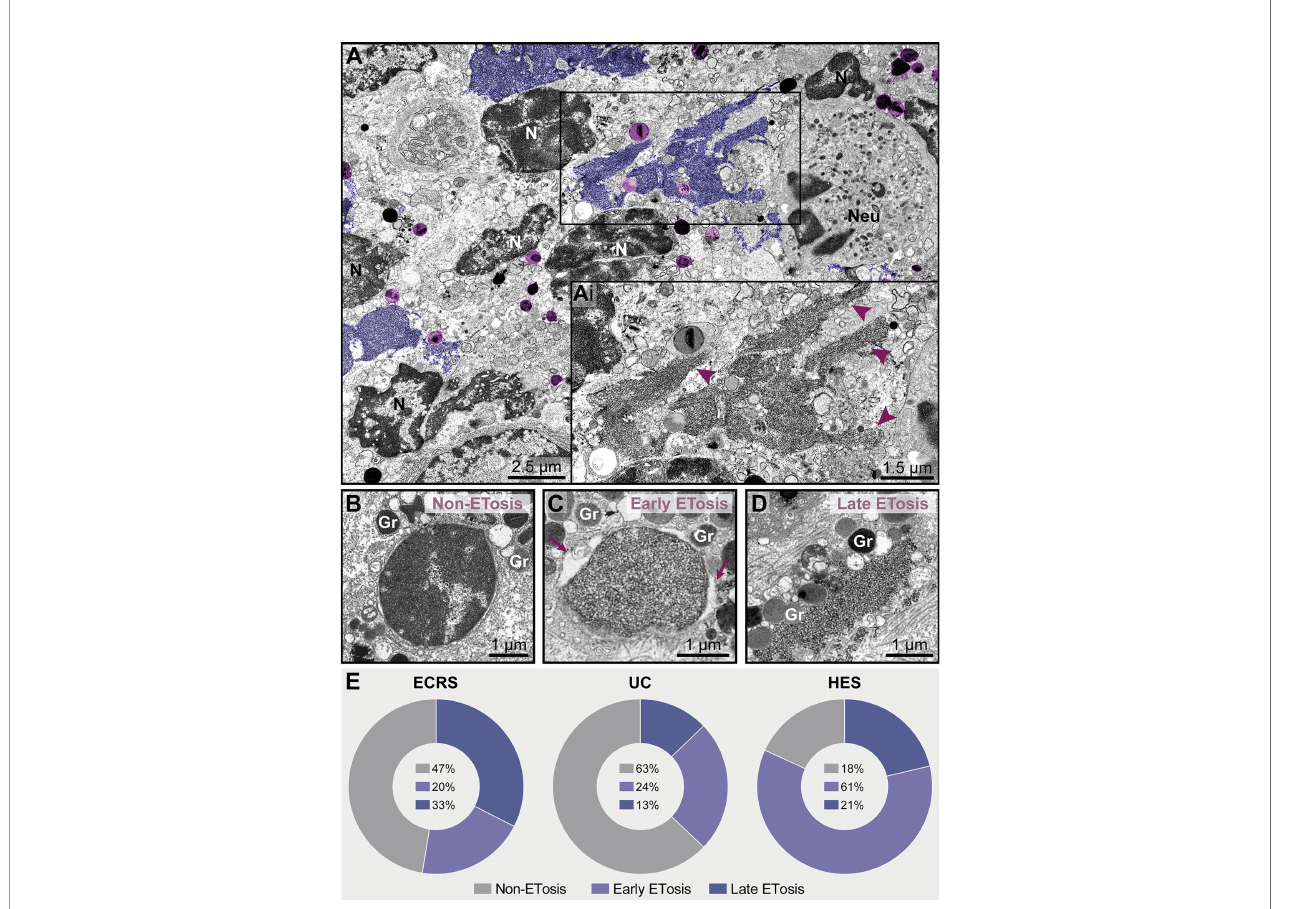
FIGURE 7 | ETosis represents a signi fi cant proportion of cytolytic eosinophils in eosinophil-associated diseases (EADs). (A, Ai) A tissue in fl ammatory site [intestinal ulcerative colitis (UC) biopsy] showing ETotic eosinophils with late signs of ETosis represented by decondensed chromatin spread extracellularly as ETs (colored in purple and indicated by arrowheads in Ai at higher magni fi cation). FEGs (light purple) are in contact with ETs. Note that other non-ETotic eosinophils with nuclei (N) exhibiting heterochromatin (condensed)/euchromatin (decondensed) and a neutrophil (Neu) are seen in the same area. (B – D) Representative electron micrographs from an ECRS biopsy (nasal sinus tissue) highlighting the structural aspect of nuclei in cytolytic eosinophils. While the presence of condensed/decondensed chromatin denotes a non-ETotic eosinophil, eosinophils in early (C) and late (D) processes of ETosis show extensively decondensed chromatin. When in early ETosis (C) , the nuclear envelope is observed and frequently displays structural changes (enlargement of the perinuclear space, arrows), in late ETosis (D) , the nuclear envelope disappears and the chromatin spreads in the extracellular matrix. Note secretory granules (Gr) immersed in the released chromatin. (E) Quantitative TEM (total tissue area of 66,000 m m 2 evaluated), reveals that ~37%-82% of all cytolytic eosinophils in EADs are in process of ETosis and that the proportion of eosinophils in early and late ETosis varies depending on the disease. A total of 151 cytolytic eosinophils with visible nuclear contents [40 for eosinophilic chronic rhinosinusitis (ECRS), 78 for ulcerative colitis (UC), and 33 for hypereosinophilic syndrome (HES)] were evaluated from biopsy samples collected from patients with ECRS (n = 2), UC (n = 16), and HES (n = 2) and prepared for